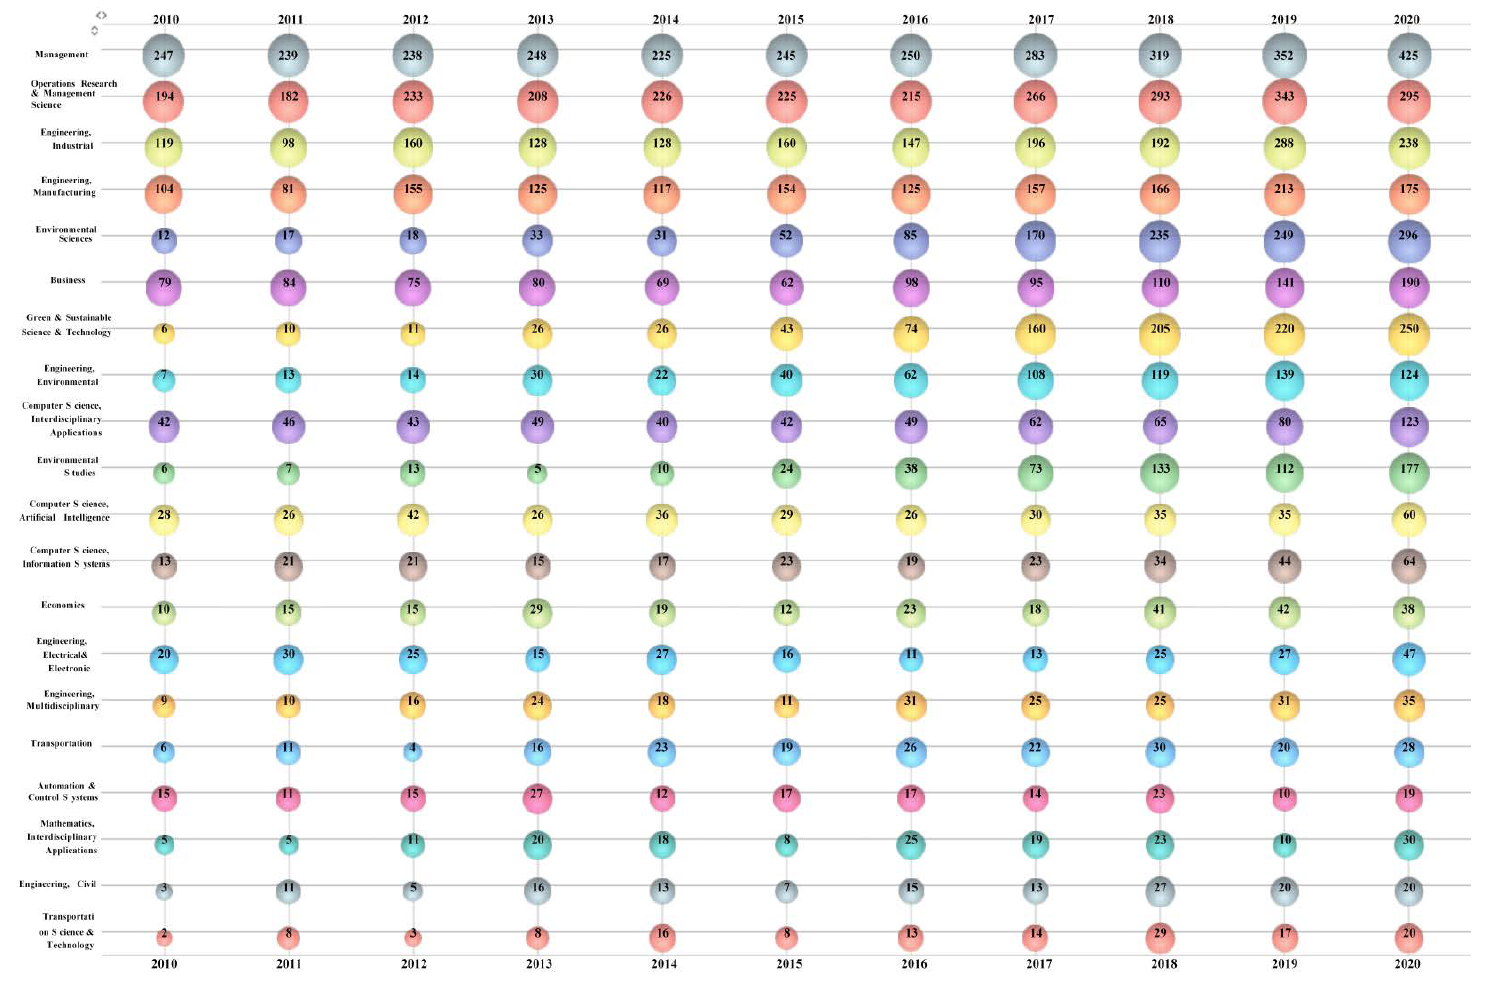
Figure 2. Bubble chart of top 20 WoS research areas in SCM.